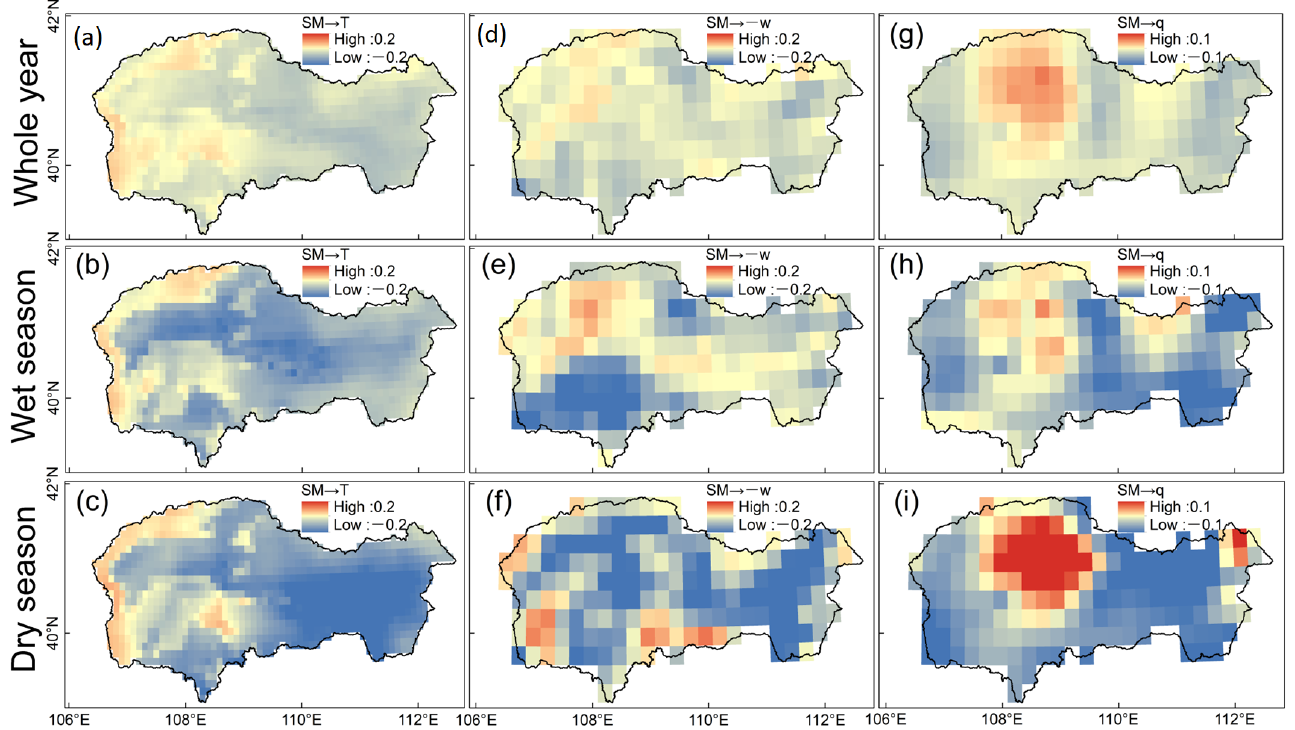
Figure 5. Soil moisture feedbacks on temperature, pressure velocity, and specific humidity in the wet and dry seasons, as well as the whole year. ( a – i ), sensitivity coefficients for SM → 2 meter tem- perature (T) ( a – c ), SM → negative pressure velocity ( −ω ) at 700 hPa (middle troposphere) ( d – f ) and soil moisture (SM) → specific humidity (q) at 700 hPa ( g – i ) identified based on the whole year ( a , d , g ), wet season ( b , e , h ) and dry season ( c , f , i ).